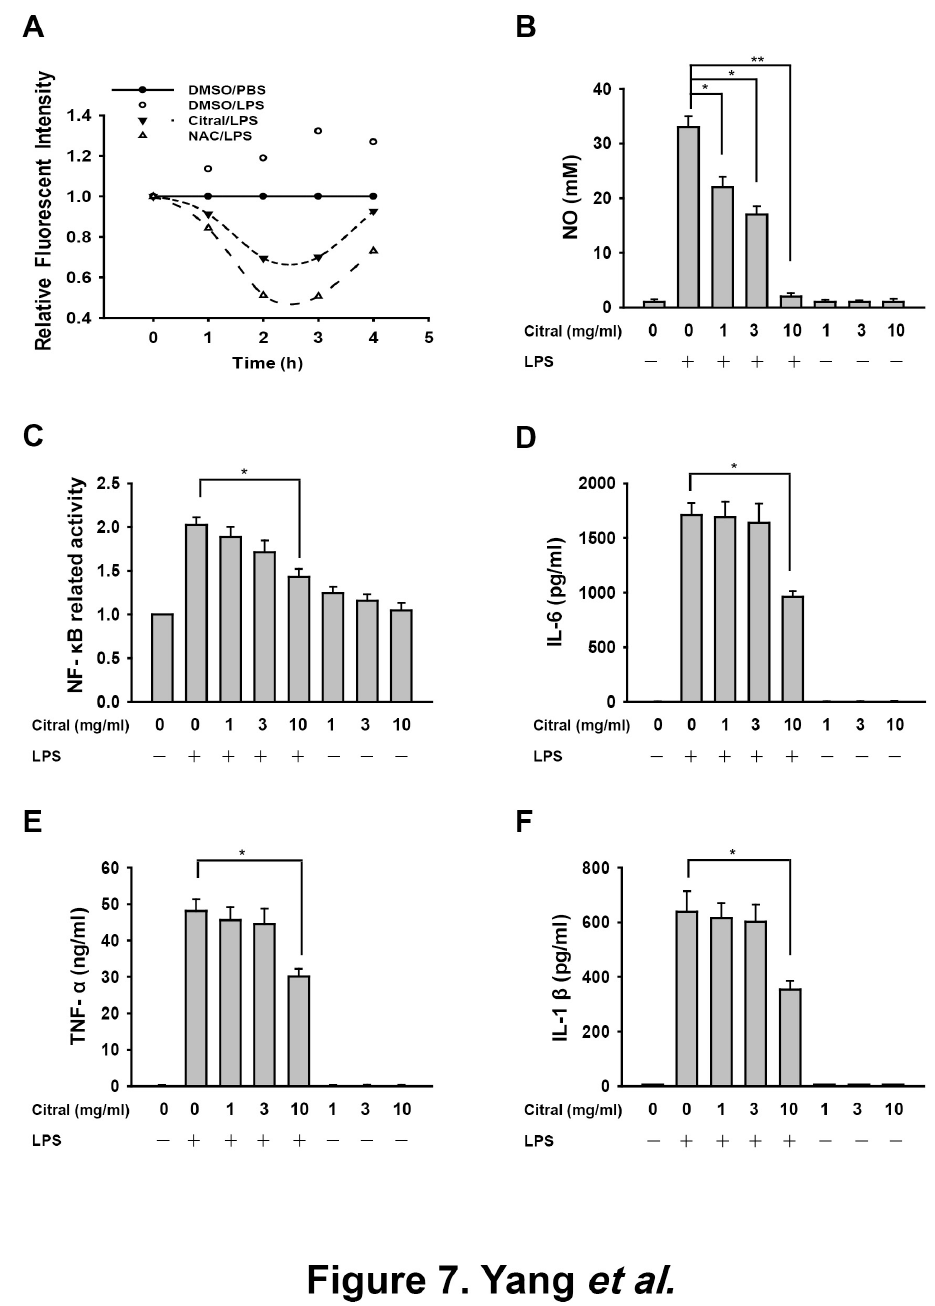
Figure 7. In vitro ROS generation and inflammatory mediator expression. (A) RAW 264.7 macrophages were incubated for 30 min with or without 10 µg/ml Citral or 10 mM N-acetyl cysteine (NAC), then for 0-4 h with or without addition of 1 µg/ml of LPS. ROS production was measured as the relative fluorescence intensity. (B) RAW 264.7 macrophages were incubated for 30 min with or without the indicated concentrations of Citral, then for 24 h with or without addition of 1 µg/ml of LPS, then NO generation in the culture medium was measured by the Griess reaction. (C) RAW-Blue TM cells were incubated for 30 min with or without the indicated concentration of Citral, then for 24 h with or without addition of 1 µg/ml of LPS, then secreted embryonic alkaline phosphatase activity was measured using QUANTI-Blue TM . (D-F) RAW 264.7 macrophages were incubated for 30 min with or without the Citral, then for 24 h with or without addition of 1 µg/ml of LPS, then IL-6 (D), TNF-α (E), and IL-1β (F) in the culture medium were measured by ELISA. The data are expressed as the mean ± SD for three separate experiments. * p < 0.05, ** p < 0.01 compared to the LPS-treated group. doi: 10.1371/journal.pone.0074871.g007 PLOS ONE |